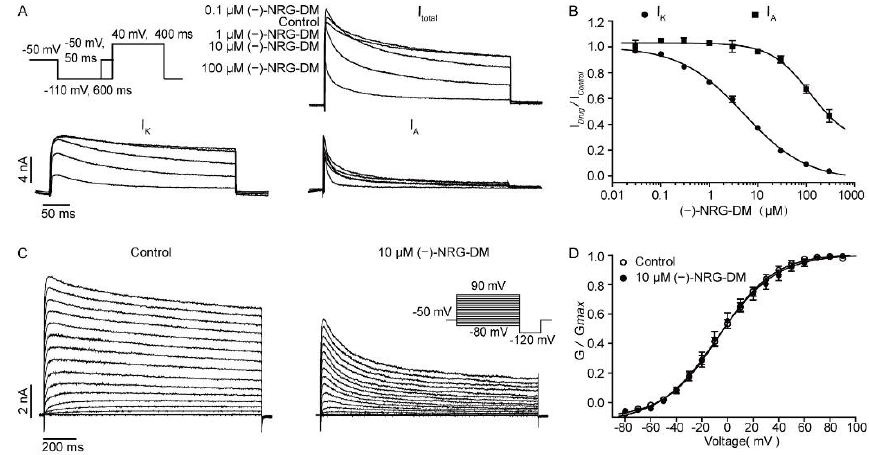
Figure 5. Inhibitory effects of ( − )-NRG-DM on the potassium currents of DRG neurons in mice. ( A ) Typical traces of the transient outward potassium currents I A and the delayed rectifier potassium currents I K in the presence of ( − )-NRG-DM at indicated concentrations. ( B ) The dose–response curve of ( − )-NRG-DM on I K and I A currents. The IC 50 values were 5.10 ± 0.04 µ M and 119.90 ± 0.03 µ M, respectively ( n = 5). ( C ) Representative activation current traces of Kv channels before and after 10 µ M ( − )-NRG-DM. ( D ) Activation curves of Kv currents before and after 10 µ M of ( − )-NRG-DM ( n = 6).